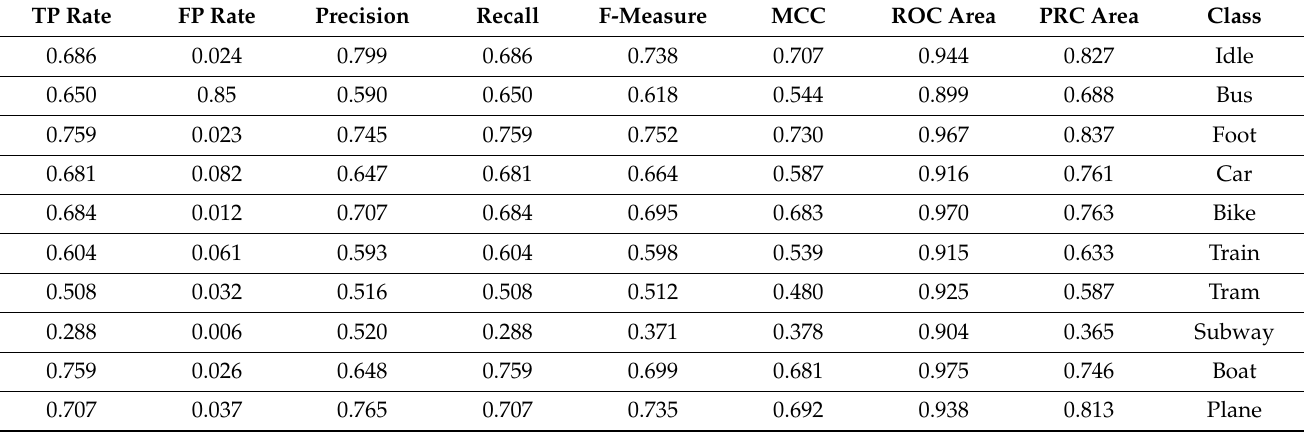
Table 4. Detailed results by class of transportation mode (RF, 10-fold).